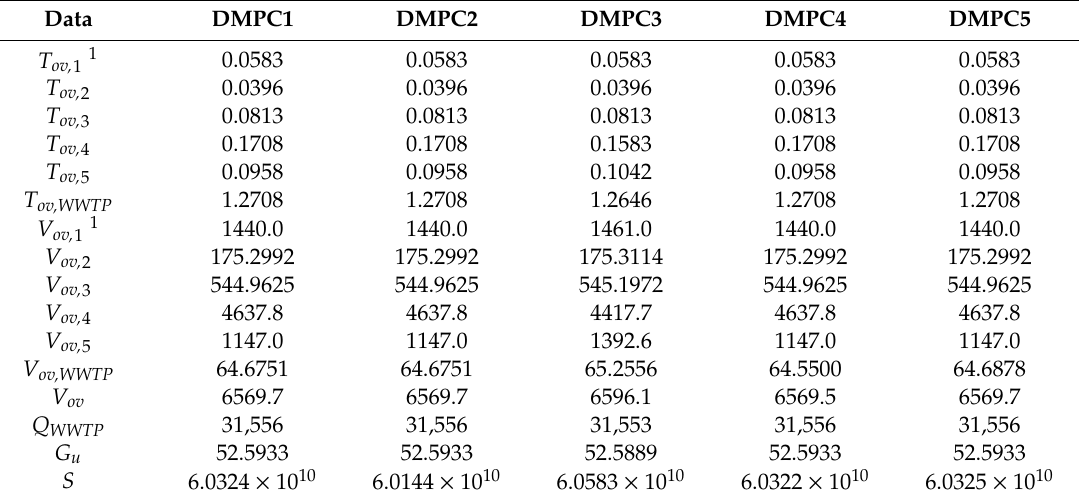
Table 8. Numeric results for scenario 1 varying DMPC fuzzy